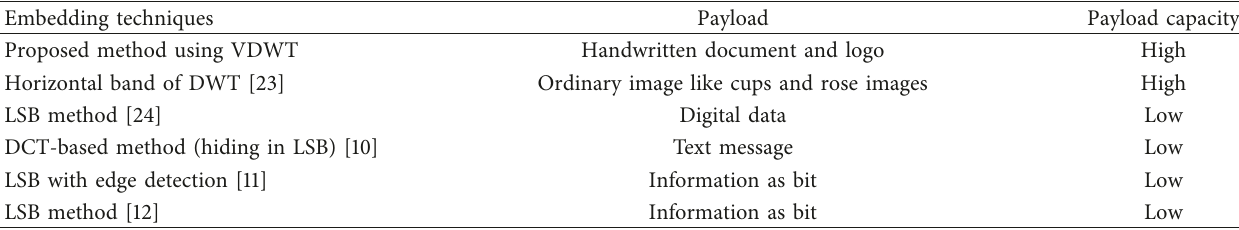
Table 1: Comparison of the payload used and its